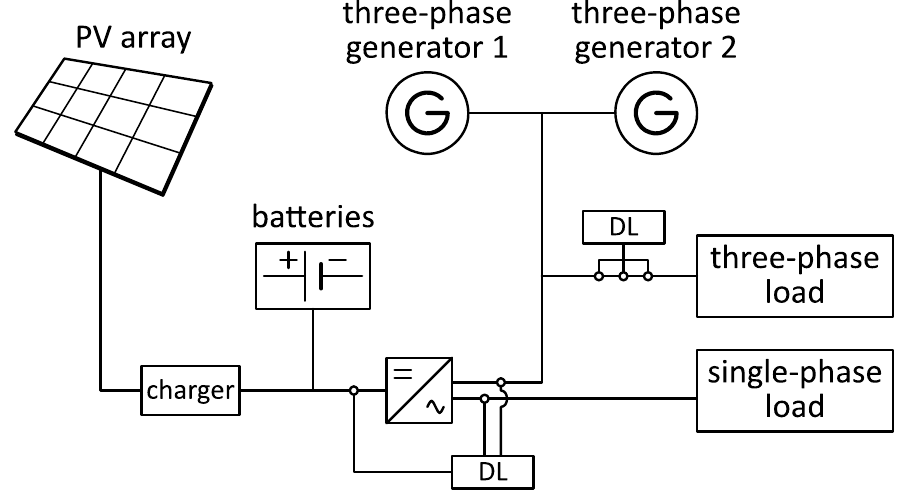
Figure 1. Electricity scheme of the Lizara hut (DL is the data